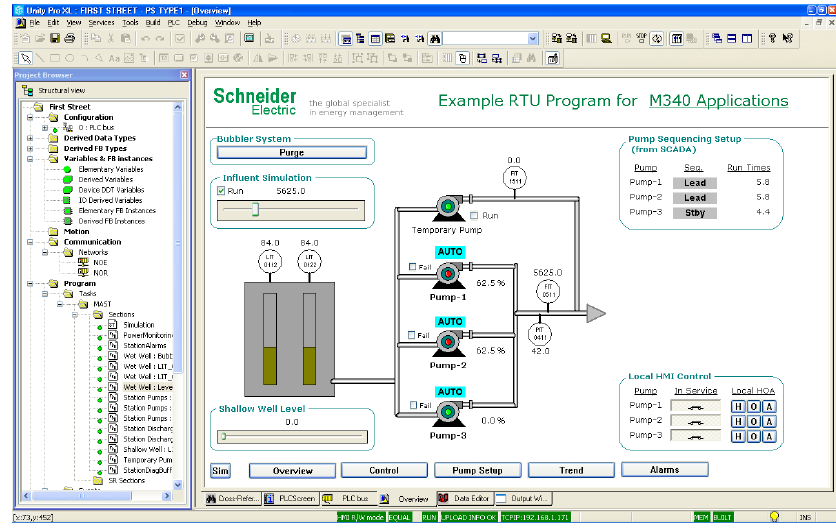
Figure 3. Unity Pro L working interface.